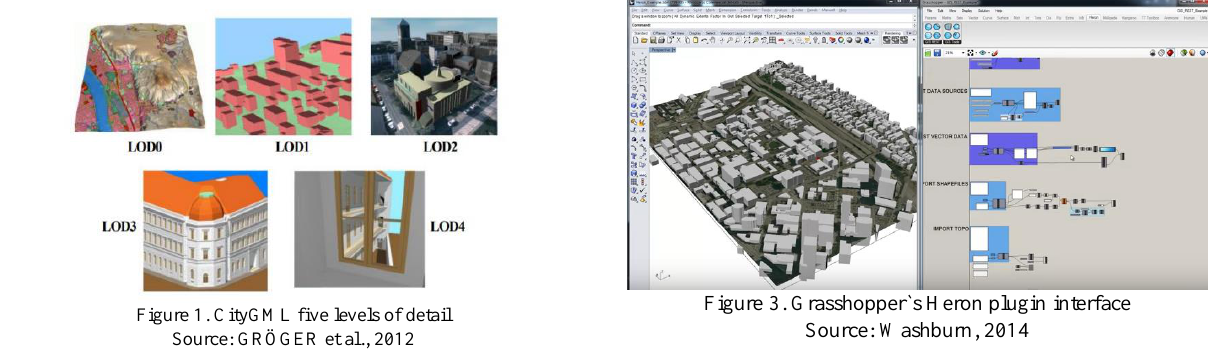
Figure 1. CityGML five levels of detail Source: GRÖGER et al., 2012